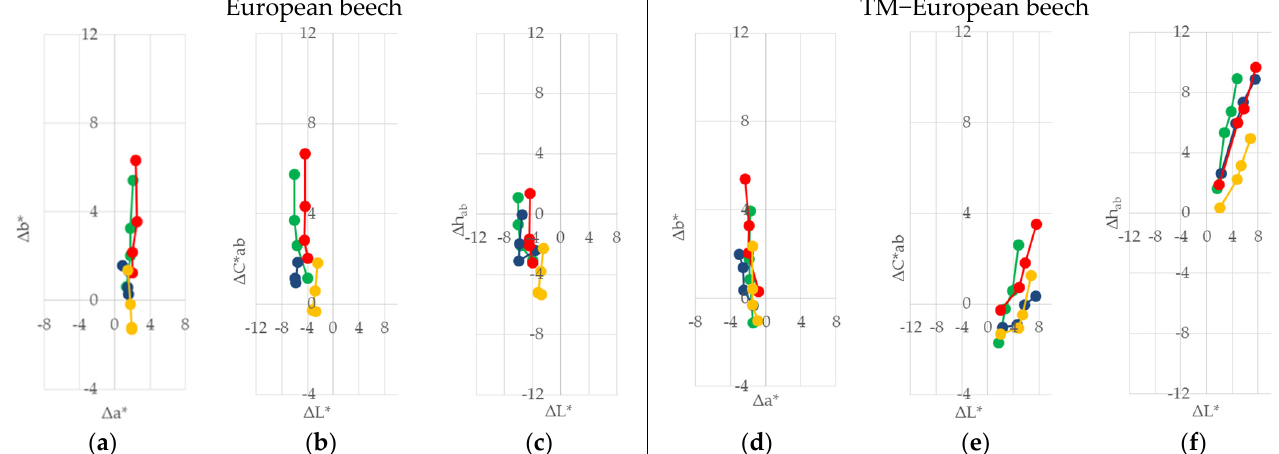
Figure 3. Changes in ∆ L* , ∆ a* , ∆ b* , ∆ C* ab , and ∆ h ab after the exposure to indoor sunlight of coated and uncoated native ( a – c ), and thermally treated ( d – f ), European beech wood for 60 days.